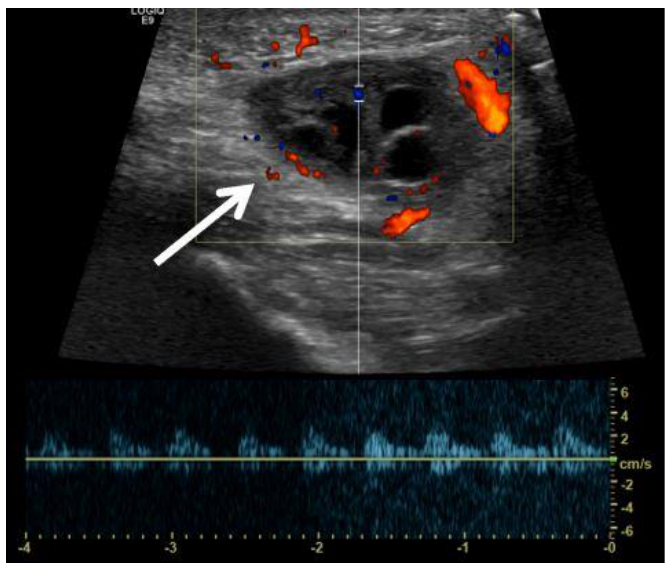
Image 3. Ultrasonography with Doppler showing an incarcerated ovary (arrow) within an inguinal